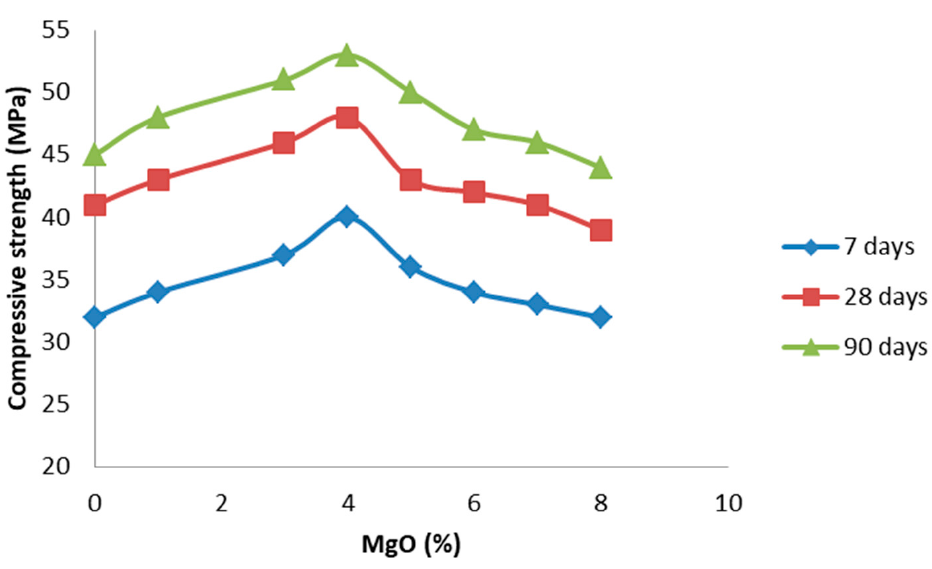
Figure 11. Pore size distribution of mortars containing MEA: ( a ) 4% MEA; ( b ) 8% MEA.